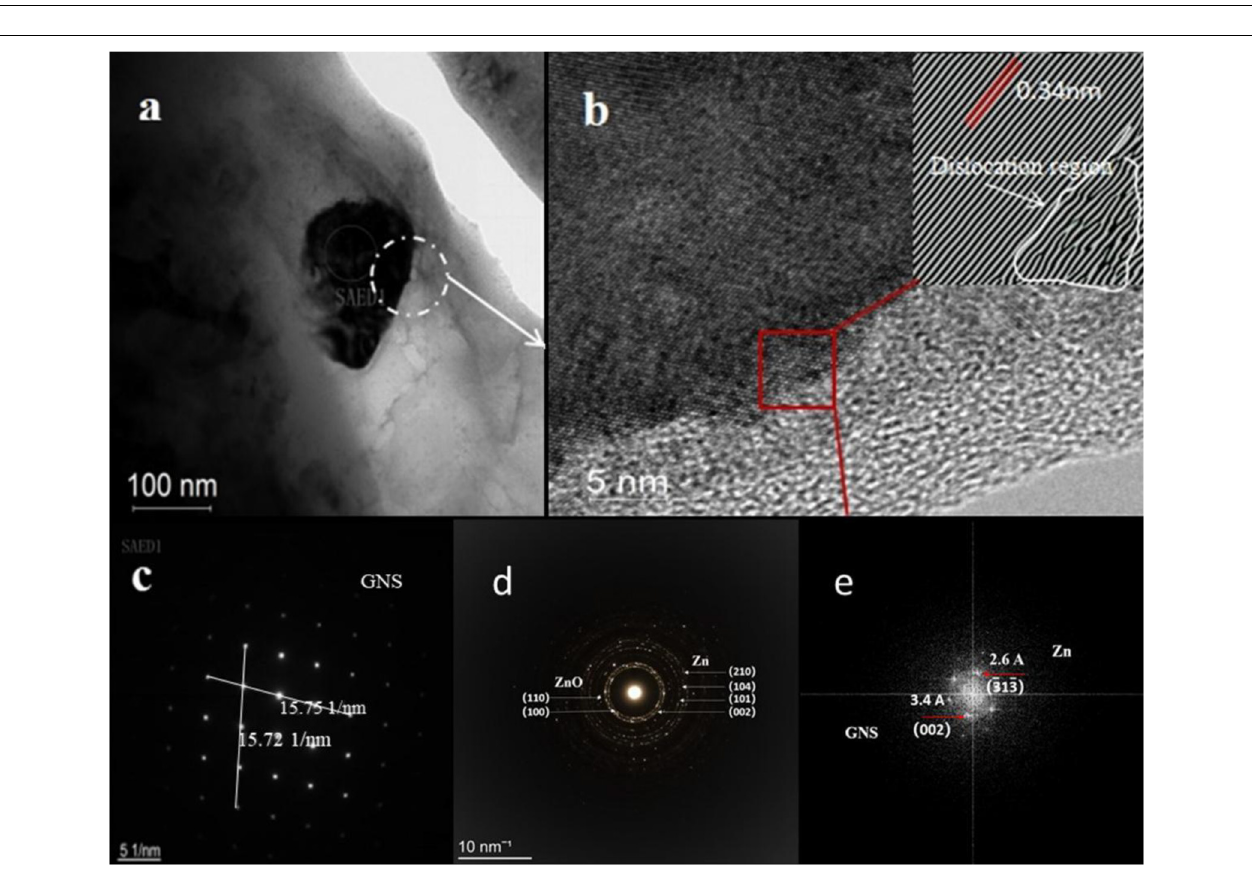
thermal expansion (CTE) between Zn and GNS (Taya,